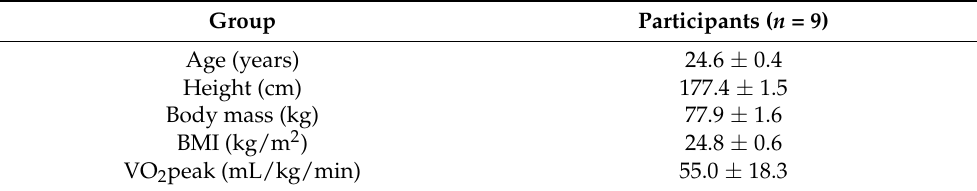
Table 1. Participant’s characteristics.